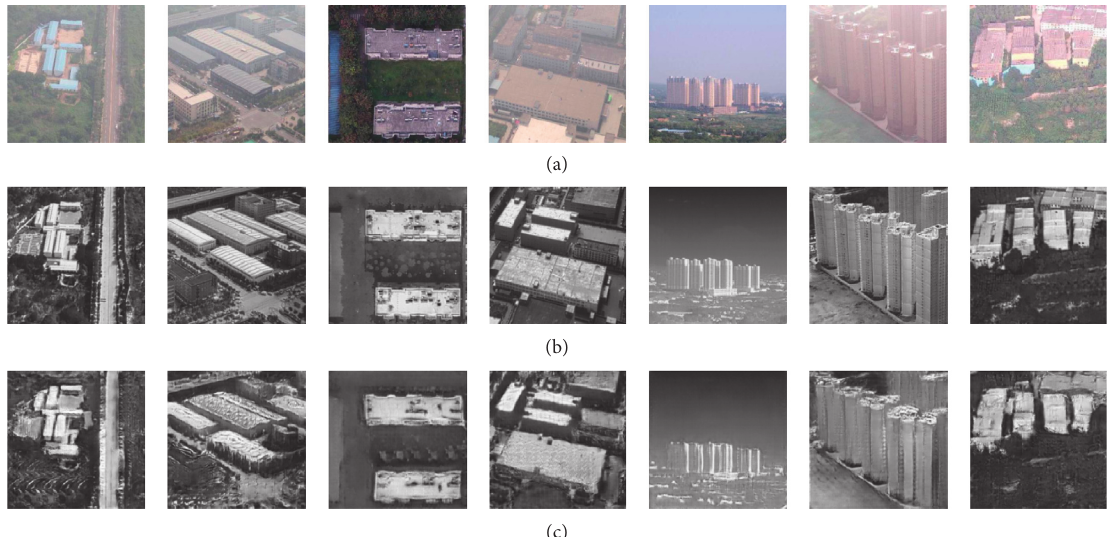
Figure 5: Examples of infrared-generated images of buildings produced on the basis of the I-GANs algorithm. (a) Visible images. (b) Real infrared images. (c) Infrared-generated images.